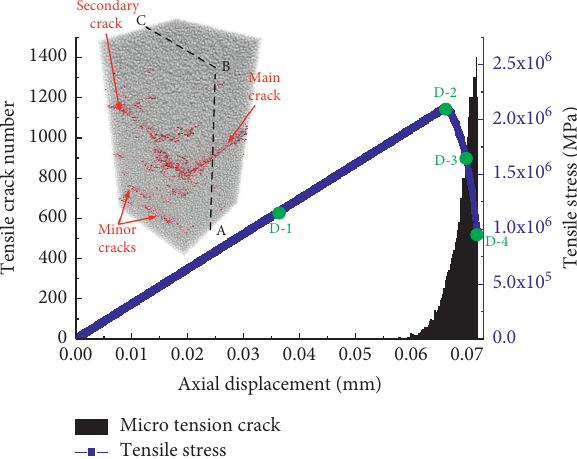
Figure 11: The failure pattern, the tensile stress, and the crack development in the DT